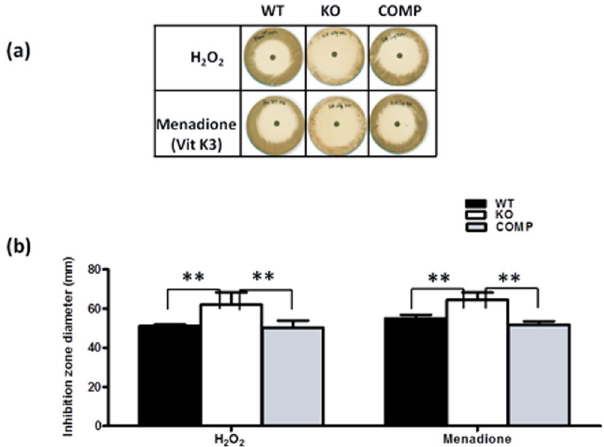
Figure 5. Role of MDP1 in the protection against ROS. Oxidative stress sensitivity assay for WT, MDP1-KO, and COMP M. smegmatis strains by analysis on agar soaked with H 2 O 2 or menadione (Vitamin K 3 ). ( a ) Plates showing growth inhibition zones. ( b ) Diameters of inhibition zones measured in mm. Data are shown as means of triplicate experiments. ANOVA was used to analyze the data and P-values < 0.01 (indicated by ** ) were considered